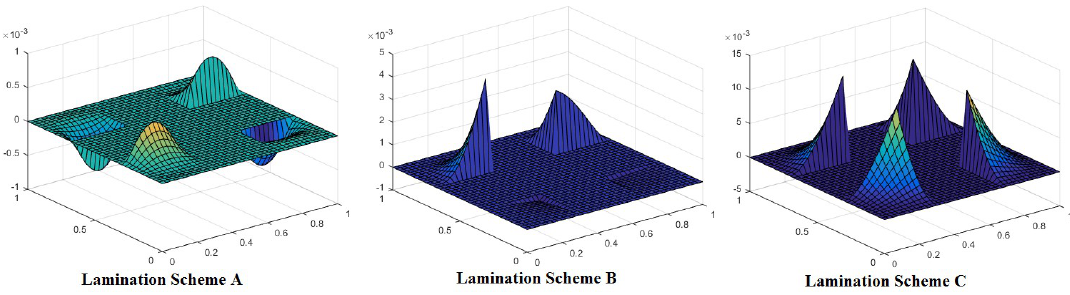
Figure 8. Mode shape for a laminated composite plate with lamination scheme B, a / h = 20, cutout size 0.4a, N x /N y = 2, N xy = 2 and CCCC boundary condition.